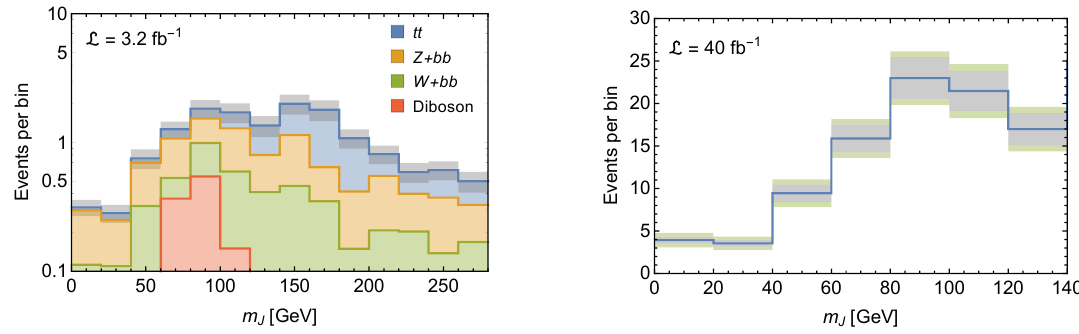
Figure 3 . Left: predicted number of events per bin for di(cid:11)erent sources of background as a function of m J for an integrated luminosity of 3 : 2 fb (cid:0) 1 , to be compared with [67]. Right: predicted total number of background events per bin as a function of m J in the low m J search window for an integrated luminosity of 40 fb (cid:0) 1 . In both cases, events with =E < 500 GeV are rejected. The gray T band in both panels indicates the uncertainties resulting from the rescaling factors, the green band in the right panel includes in addition the uncertainties resulting from limited MC